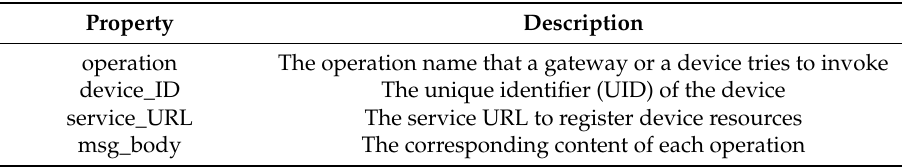
Table 2. Operation properties.